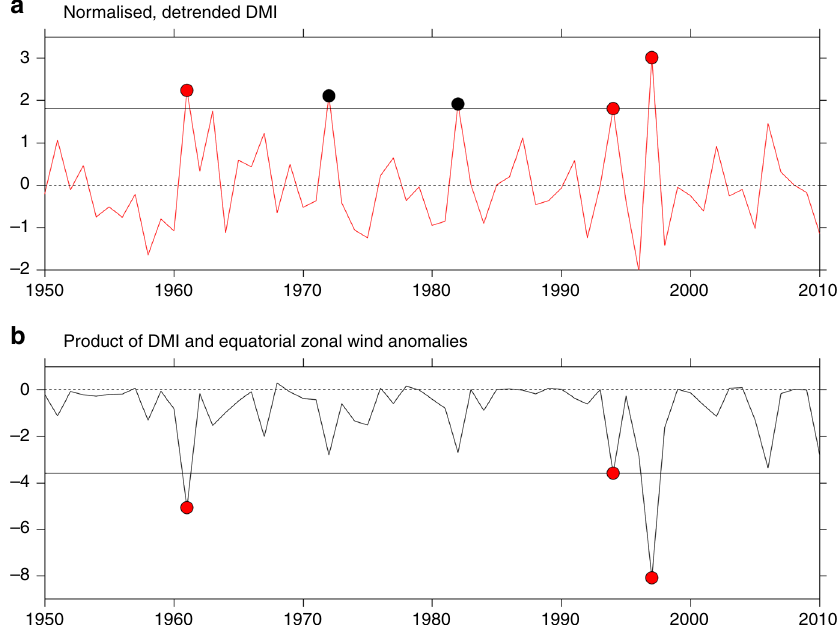
Fig. 1 Comparison of SST-based dipole mode index and a proxy of nonlinear zonal advection. a The dipole mode index (DMI) as traditionally de fi ned 1 cannot clearly distinguish the 1961, 1994, and 1997 extreme pIOD events from other events. b Product of the DMI and zonal wind anomalies averaged over the equatorial Indian Ocean area (60° E – 100° E, 5° S – 5° N), which approximates the equatorial nonlinear zonal advection, clearly shows the distinction of the extreme pIOD from other events. Red dots indicate three observed extreme pIOD events (1961, 1994, and 1997). The black horizontal line indicates the value of the 1994 extreme pIOD, which is the weakest among the three extreme pIODs. Comparison between a , b highlights that the traditional DMI cannot distinguish extreme events from typical IOD events (indicated by black dots in a